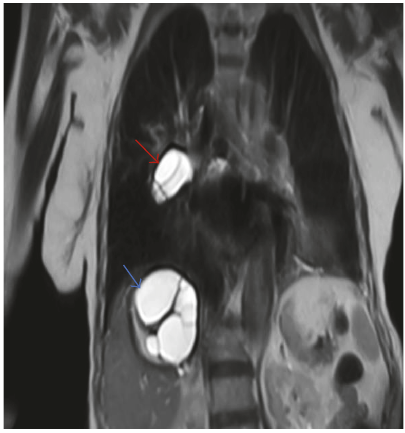
Figure5:AcoronalT2weightedimageshowsahighsignalintensity cystic lesion (red arrow) within the right main pulmonary artery with multiseptate high intensity cystic lesion on the right hepatic lobe (blue arrow).